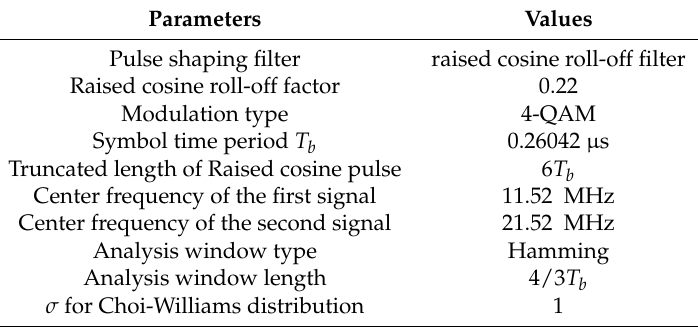
Table 1. Simulation